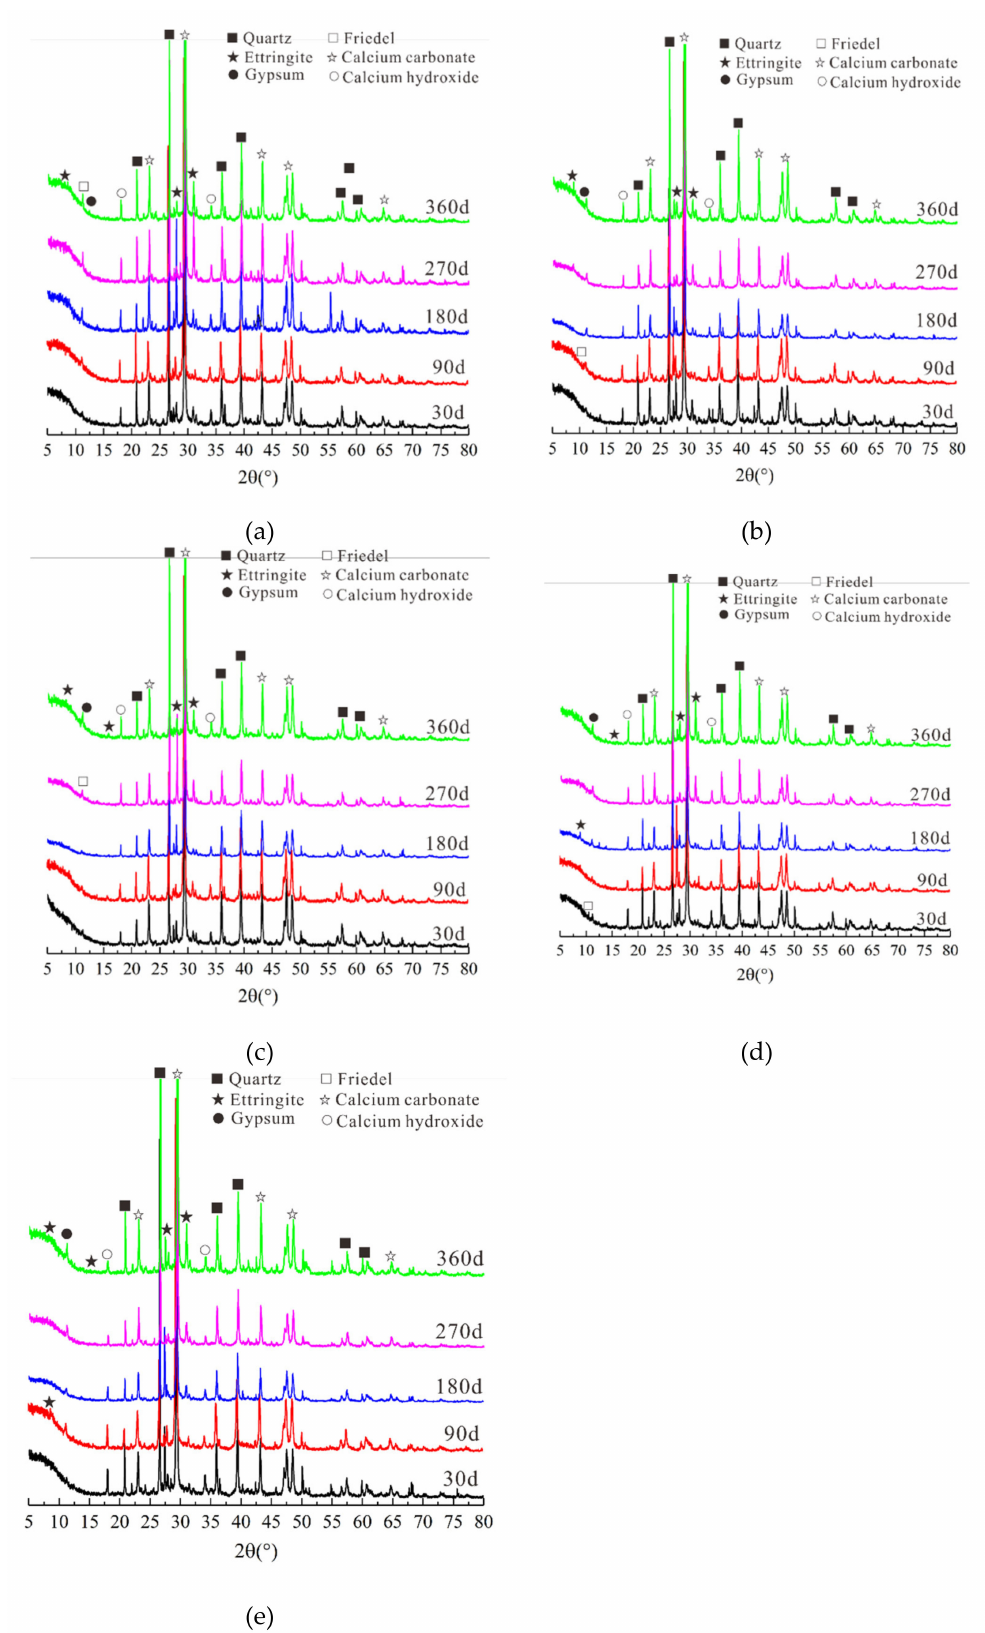
Figure 8. Mineral analysis results after corrosion for the specimen: ( a ) CS0, ( b ) CS0.5, ( c ) CS1, ( d ) CS2, ( e )